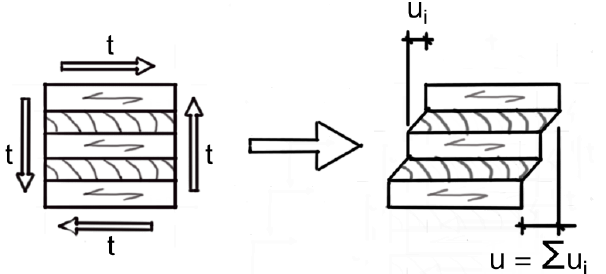
Figure 4. Shear deformations between layers of a cross laminated timber plate cross-section according to Mestek et al. [13], where t are the applied shear forces, u i the resulting deformation of a transverse layer, and u the total deformation of the plate. Redrawn and adapted by the authors.